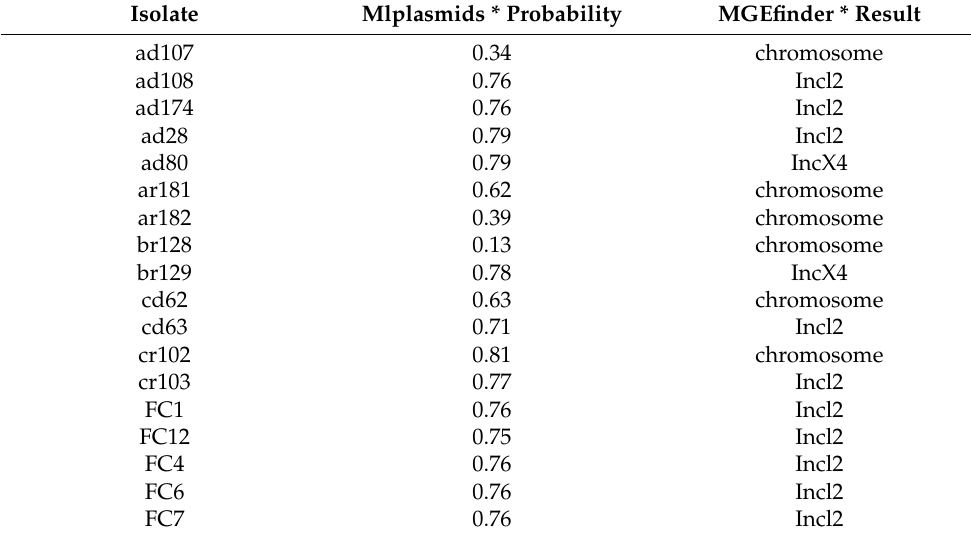
Table 2. Results of the in silico analysis of the mcr-1 gene location. Isolate Mlplasmids * Probability